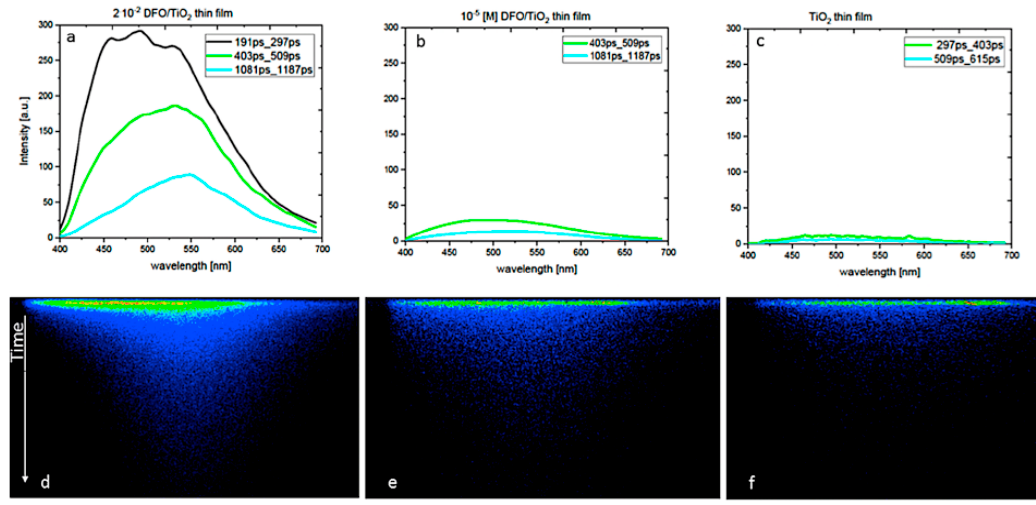
Figure 3. Time-resolved emission spectra of DFO/TiO 2 thin films at several DFO concentrations (( a , d ) 2 × 10 − 2 [M] DFO/TiO 2 ; ( b , e ) 1 × 10 − 5 [M] DFO/TiO 2 ; and ( c , f ) 0 [M]DFO/TiO 2 ) at room temperature (T = 293 K). The excitation wavelength was 380 nm.